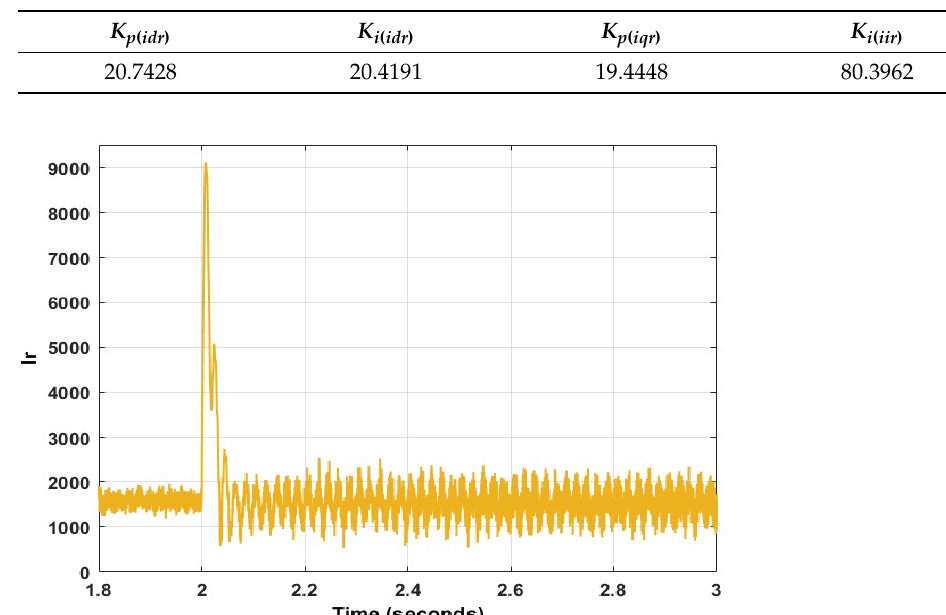
Table 8. PI controller gains at 90% dip.